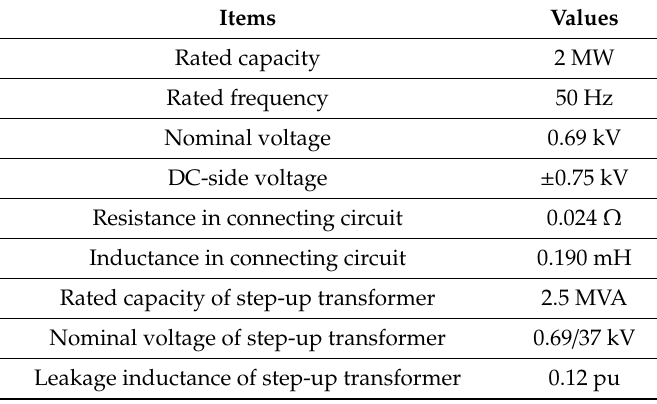
Table 3. Parameters of Type-IV wind